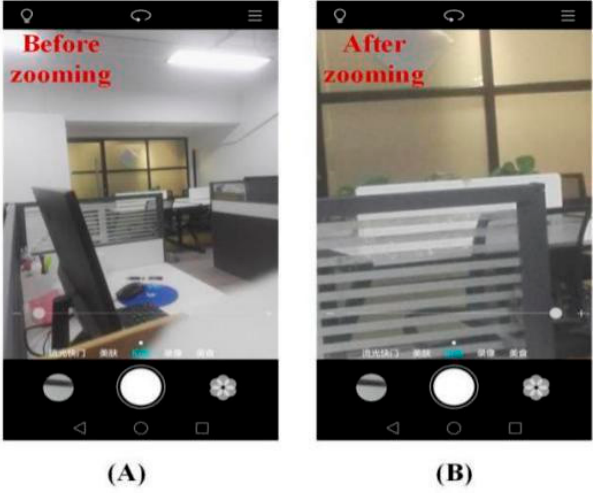
Figure 5. Two mobile photos taken in normal environment. The zoom function of the cell phone camera can be operated manually in the interface. ( A ) Photo before zooming. ( B ) Photo after zooming.